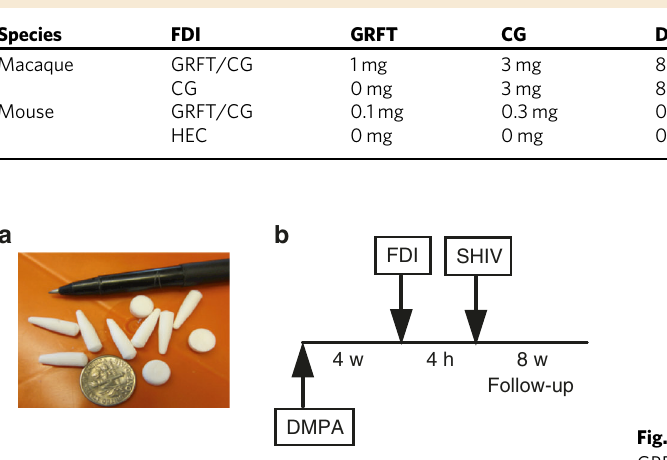
washes of approximately 300-fold the anti-HSV-2 EC 90 (12 ng/ml based on GRFT concentration) (Fig. 5). GRFT/CG FDIs also protected 10 of 10 mice against HPV16 PsV infection using in vivo luciferase expression from the reporter gene for detection and a PsV inoculum that infected 7 of 10 control HEC FDI-treated mice (Fig. 4e, f). Comparison of the log-transformed radiances revealed that protection by the GRFT/ CG FDI was highly signi fi cant vs. HEC FDI ( p < 0.0001, ANOVA with Bonferroni ’ s correction). In contrast, radiance values in mice administered GRFT/CG FDIs were not different from back- ground values in D-PBS treated mice that were not challenged. GRFT is safe and minimally absorbed after repeated use . To further probe the safety of GRFT, we performed toxicology stu- dies. Repeated dosing of GRFT and GRFT/CG in small animal models revealed no adverse fi ndings at any dose levels tested, and showed that GRFT/CG gel is non-irritating (Table 3). 7 days of daily vaginal application of 0.1% GRFT/CG gel did not enhance the susceptibility of mice to HSV-2 infection when compared to the D-PBS control ( p = 0.7152, Fisher ’ s exact test). 14 days of daily intravenous administration of GRFT up to 8.3 mg/kg/day in rats resulted in no detectable anti-drug-antibodies (ADA) and a no adverse effect level (NOAEL) of 8.3 mg/kg/day despite high systemic levels of GRFT. Fourteen days of daily vaginal GRFT/CG gel dosing (up to 0.3% GRFT) in rats resulted in a NOAEL of 0.3% GRFT and little or no vaginal irritation. This regimen also